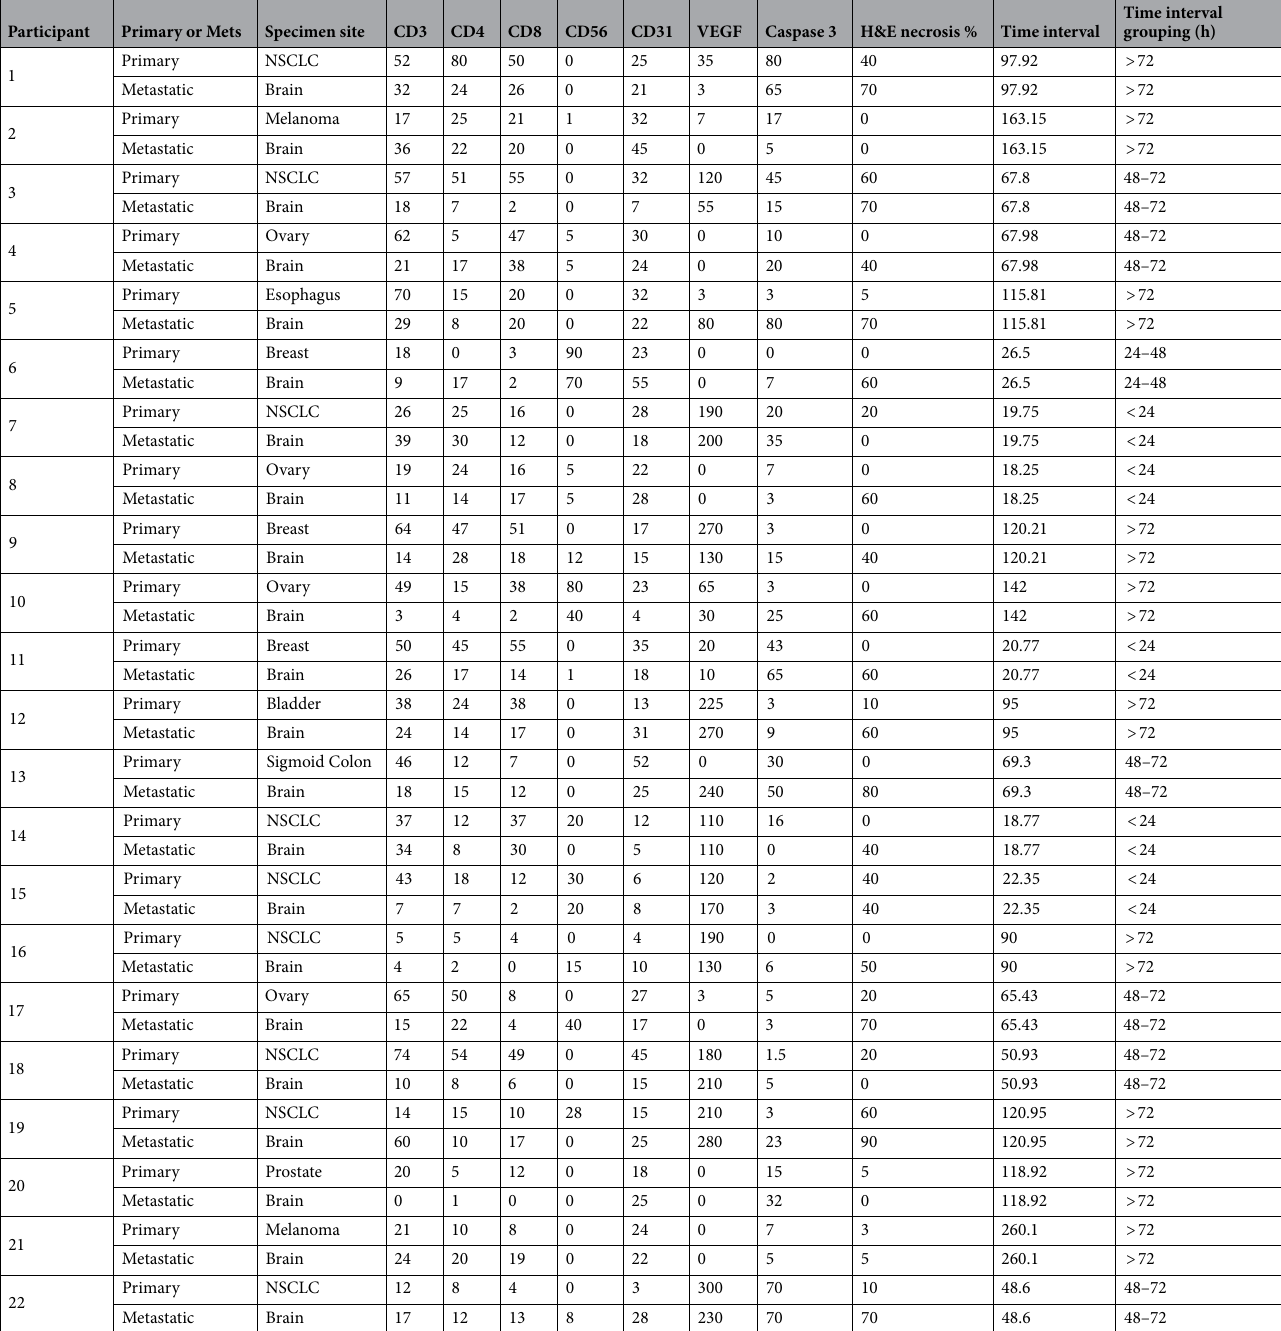
Table 2. Immunohistochemistry scores of the matched non-irradiated primary tumor tissues and brain metastasis treated with pre-operative stereotactic radiotherapy and resection. CD3 cluster of differentiation 3, CD4 cluster of differentiation 4, CD8 cluster of differentiation 8, CD56 neural cell adhesion molecule, CD31 platelet/endothelial cell adhesion molecule-1, VEGF vascular endothelial growth factor, Caspase 3 caspase protein 3, H&E hematoxylin and eosin, % percentage, NSCLC non-small cell lung